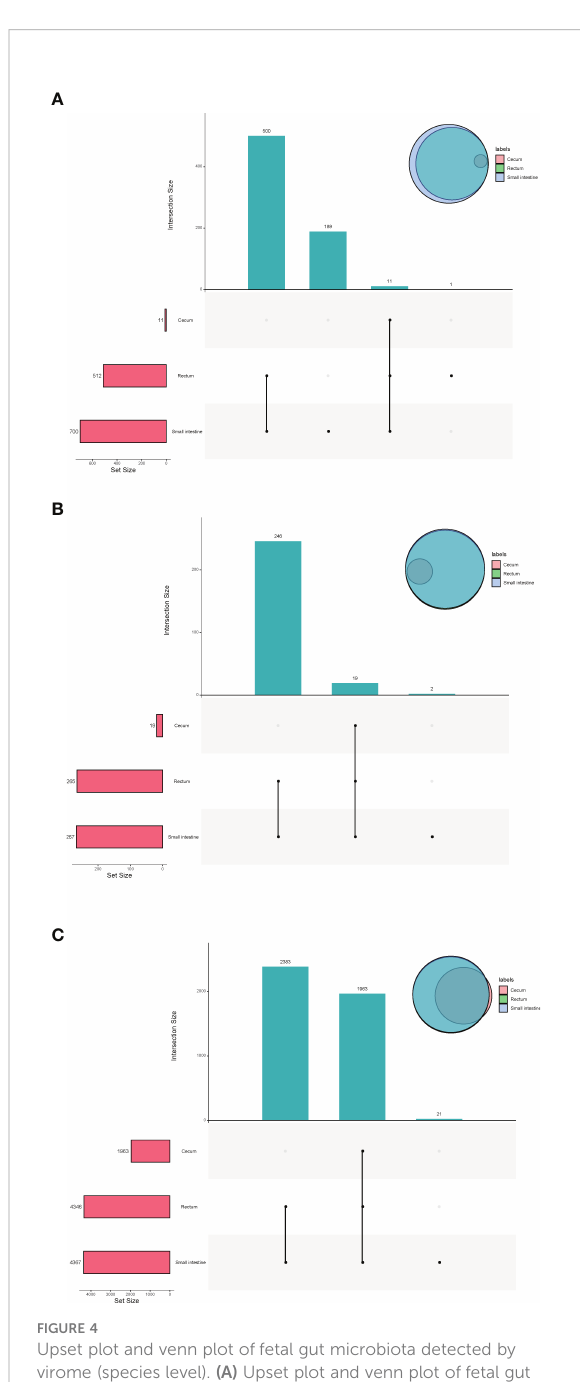
FIGURE 4 Upset plot and venn plot of fetal gut microbiota detected by virome (species level). (A) Upset plot and venn plot of fetal gut virus in three different parts. (B) Upset plot and venn plot of fetal gut archaea in three different parts. (C) Upset plot and venn plot of fetal gut bacteria in three different